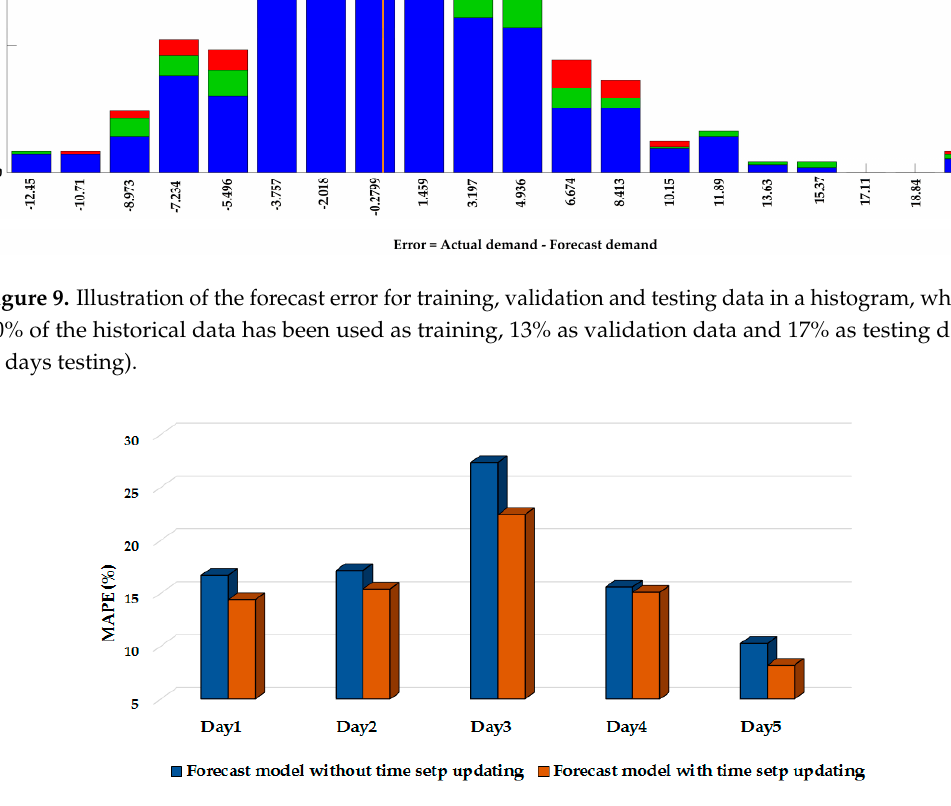
Figure 10. The daily MAPE for the RTG crane demand forecast model with and without time step updating method every time step based on the real-time readings and forecast errors.